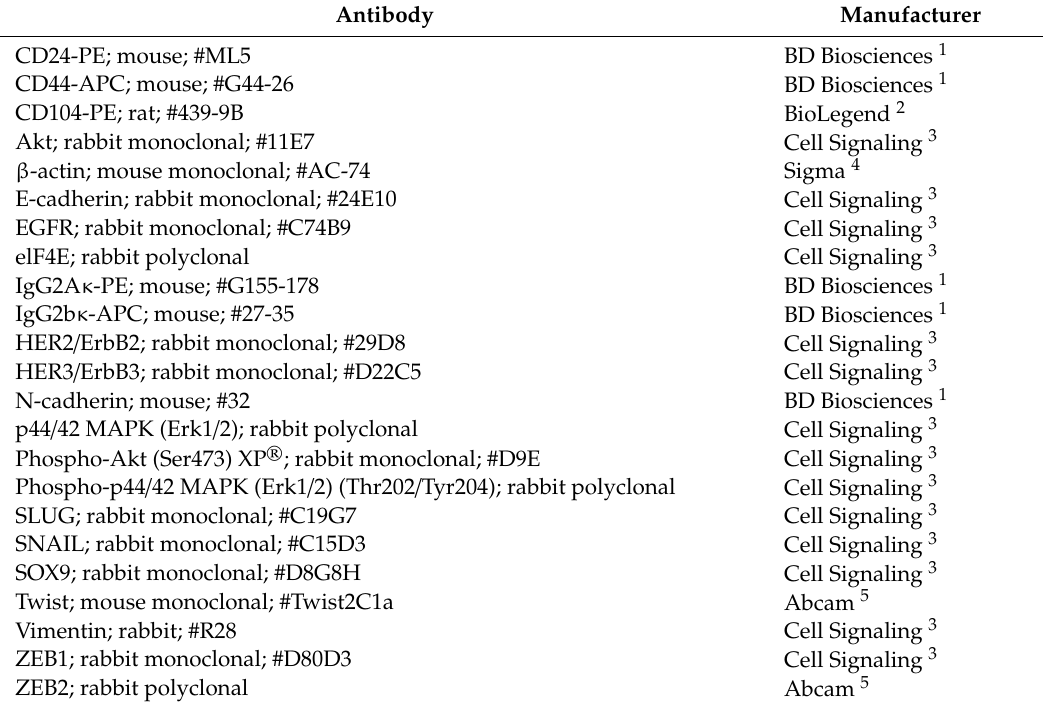
Table 1. List of all antibodies used for flow cytometry and Western blot